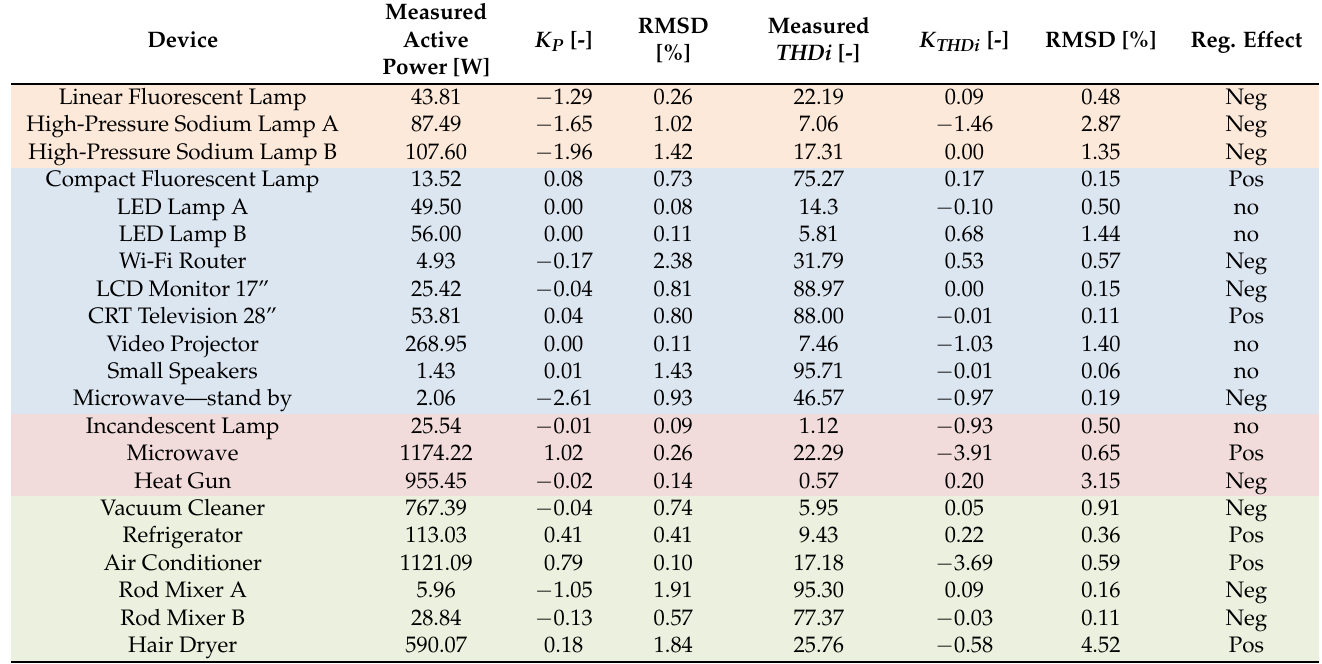
Table 4. Results of analyzed single-phase home appliances.